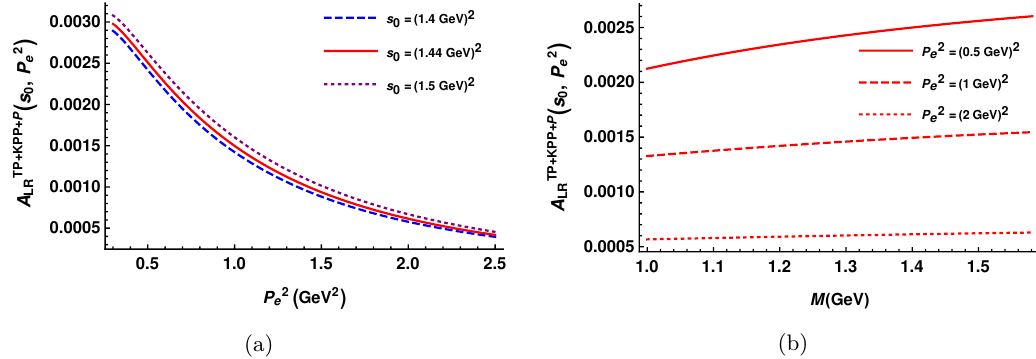
, F KPP and F P . LR LR LR